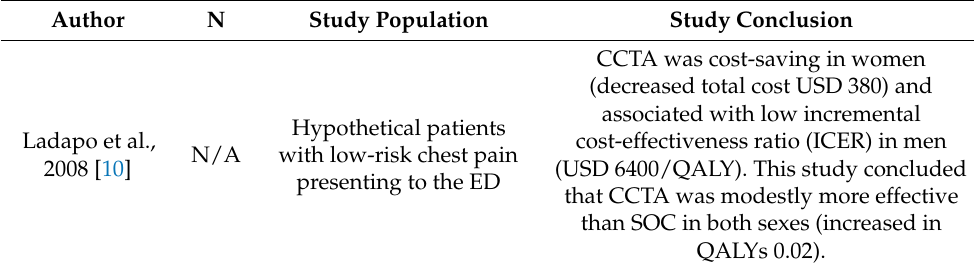
Table 1. Summary of Major Cost Effectiveness Studies for CCTA in Patients with Acute Pain